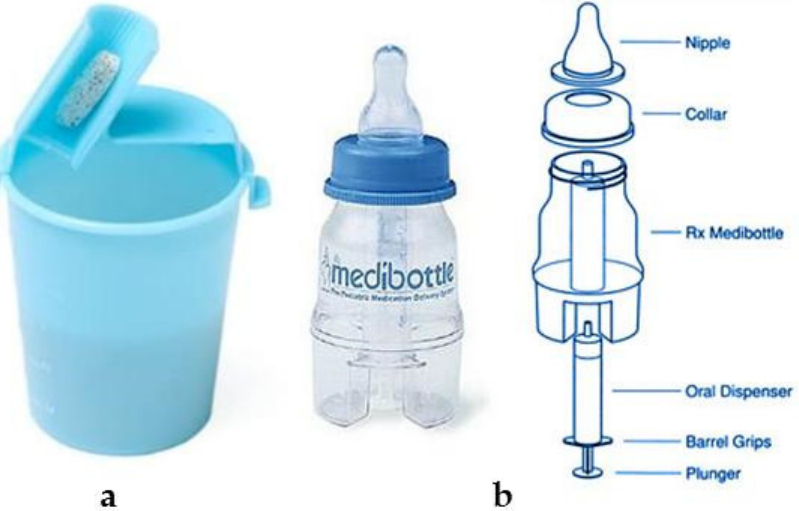
Figure 2. ( a ) ORALFLO™ cup; ( b ) Medibottle ® medication delivery